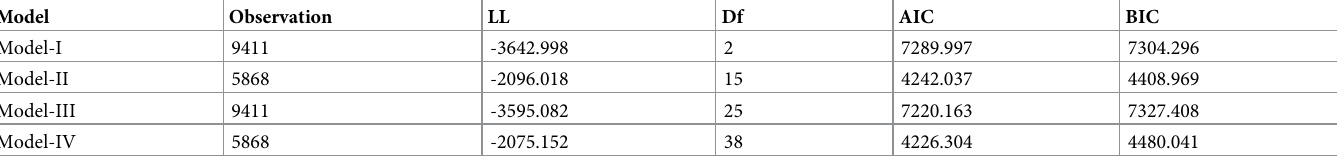
Table 3. Comparison of multi- level model for childhood febrile illness Ethiopia 2016. Model